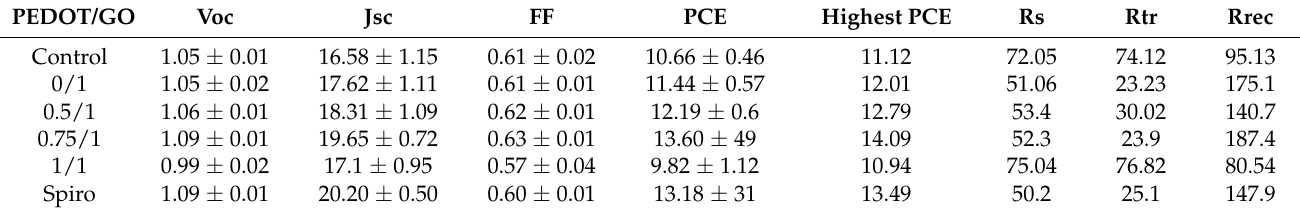
Table 1. Photovoltaic parameters of PSCs (Sweep speed of 0.25 V s − 1 , voltage range 0 V–1.2 V, electrode area of 0.06 cm 2 ).